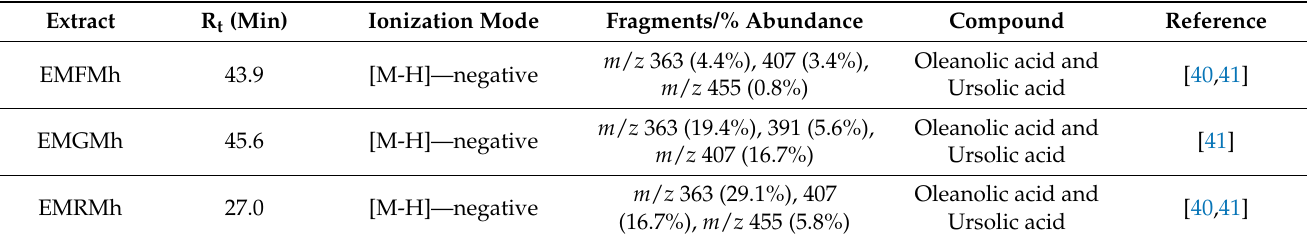
Table 3. Analysis of extracts of M. hirsuta leaves, branches, and roots by LC-MS. Extract R t